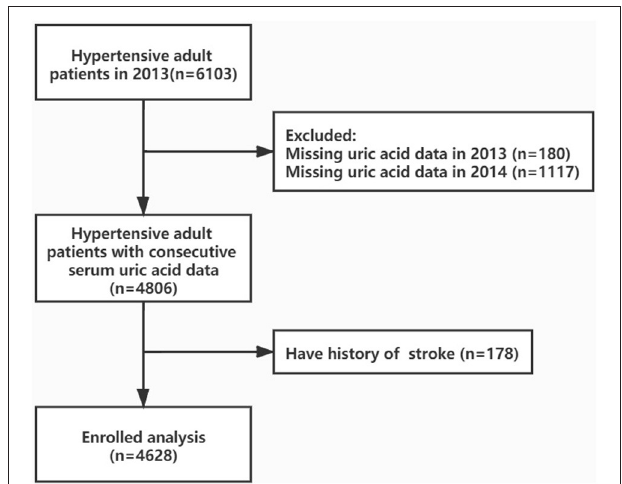
FIGURE 1 | Research flow